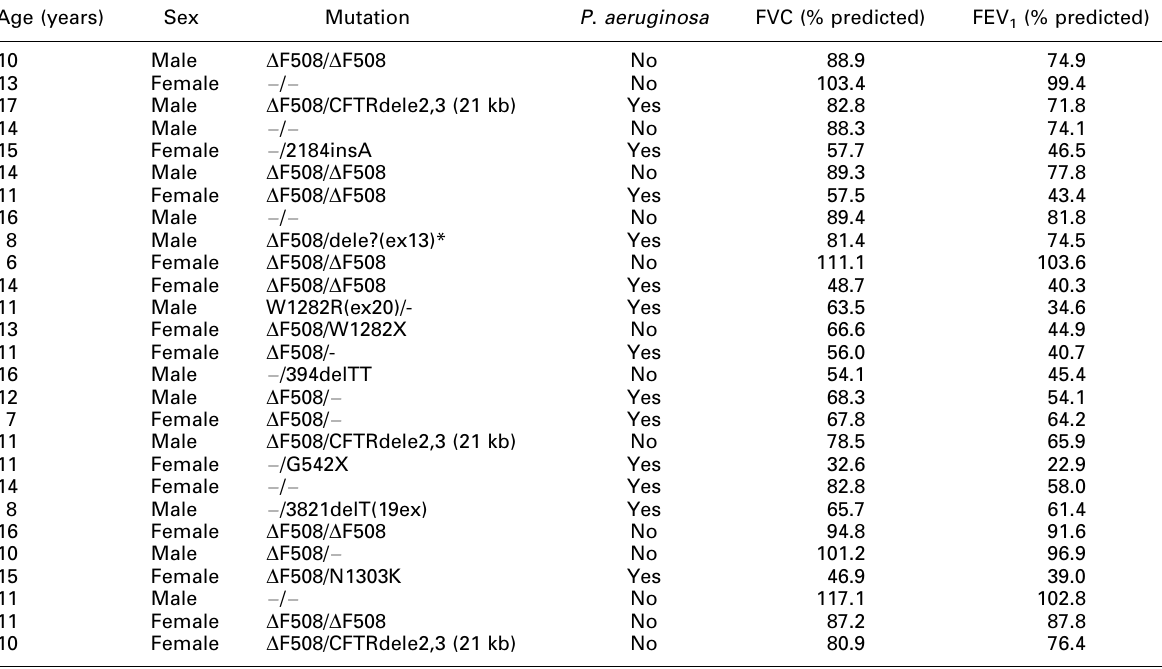
Table 1. Characteristics of the study patients Age